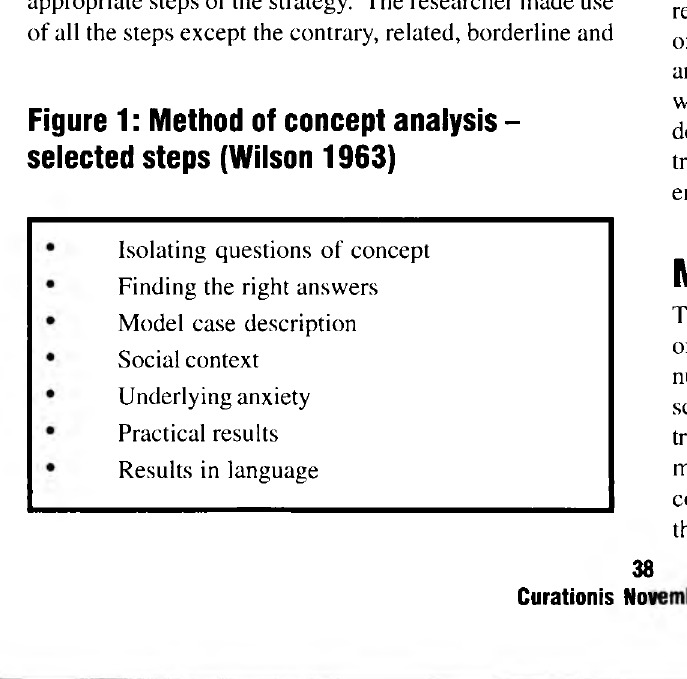
Figure 1 : Method of concept analysis - selected steps (Wilson